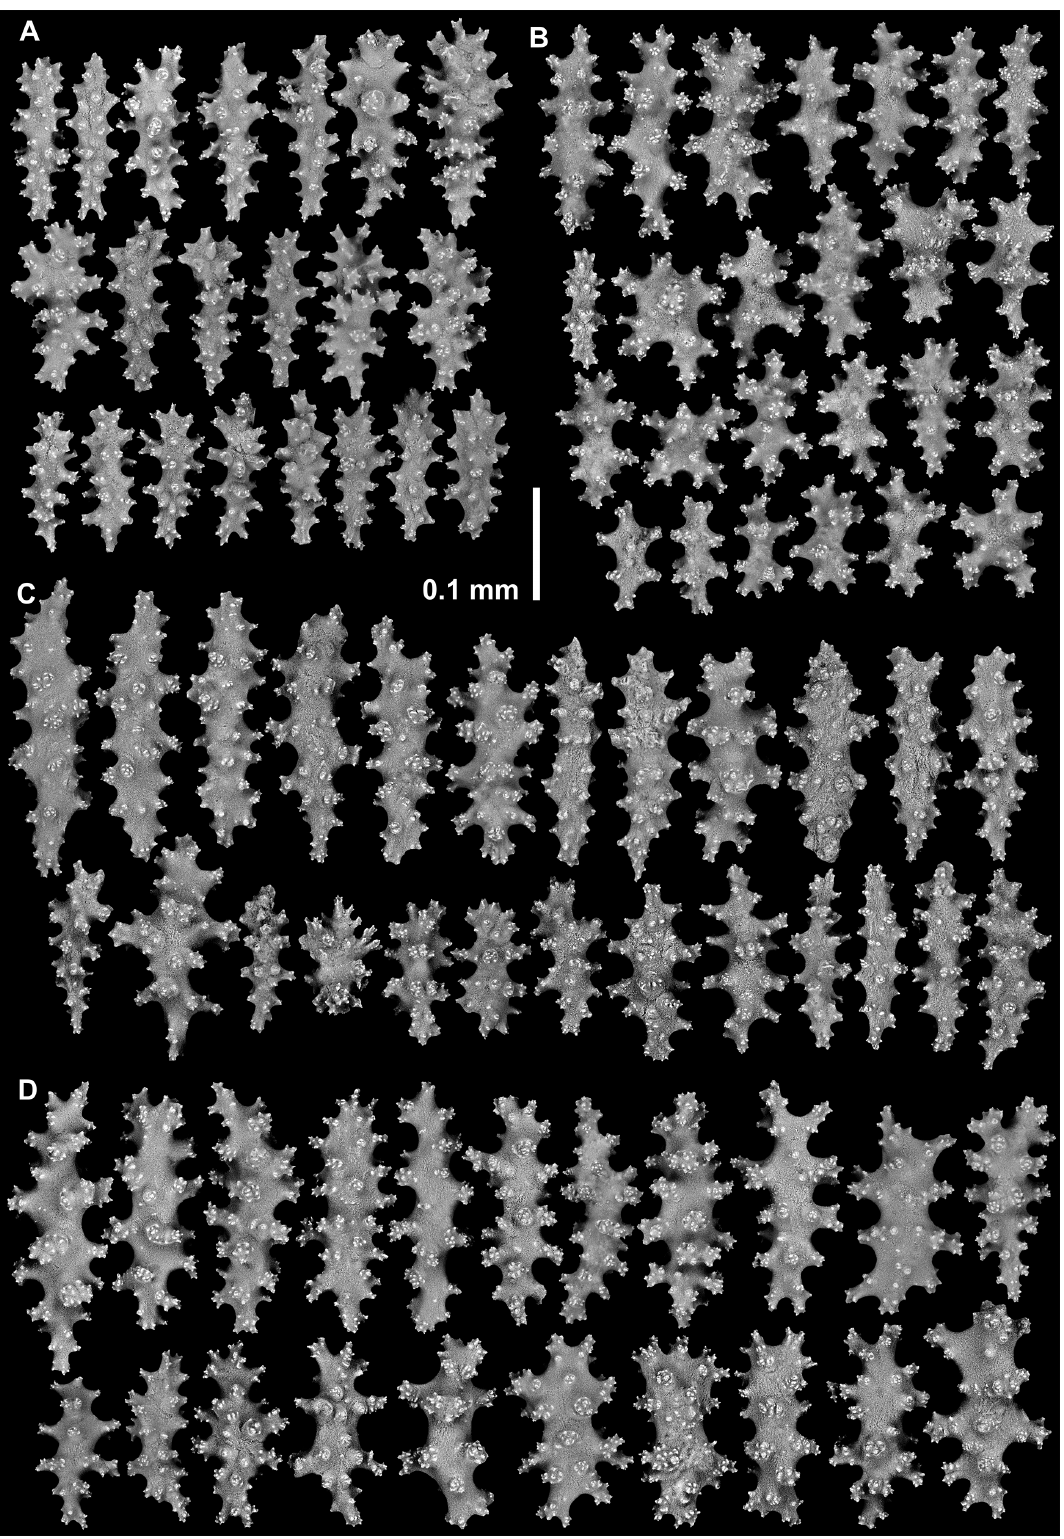
Fig. 36. Ushanaia solida gen. et sp. nov., holotype (NIWA 102133), SEMs of sclerites. A . Polyp mound. B . Lobe surface, proximal region (close proximity to substrate). C . Lobe surface, distal region. D .